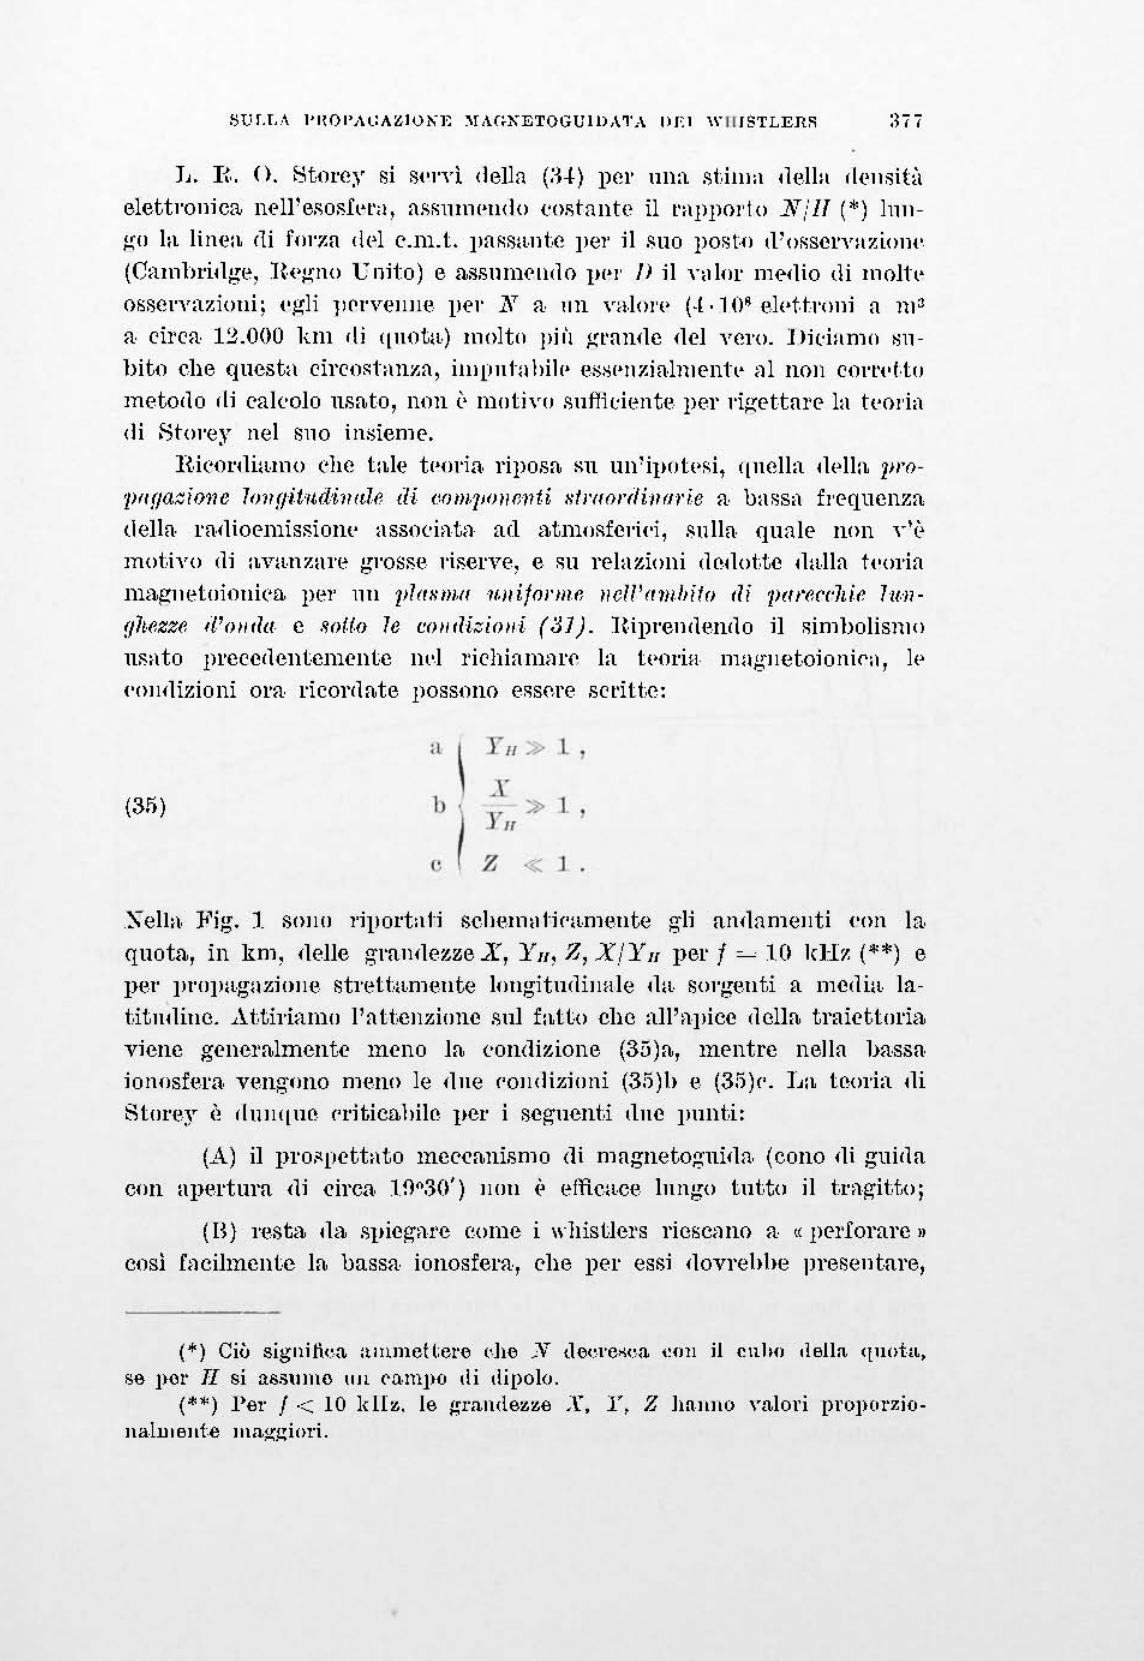
:\elb Fig. l sono riportnl-i schemul-ir'amente gli alHIamenti ('on \a. quota, in km, /lelle gran/lezze X, YII, Z, X/YII per j "----' lO 1cHz (**) e per propagnzione strett.ament.e longitu(1inale ~la· sOl'gent.i a me(lia·